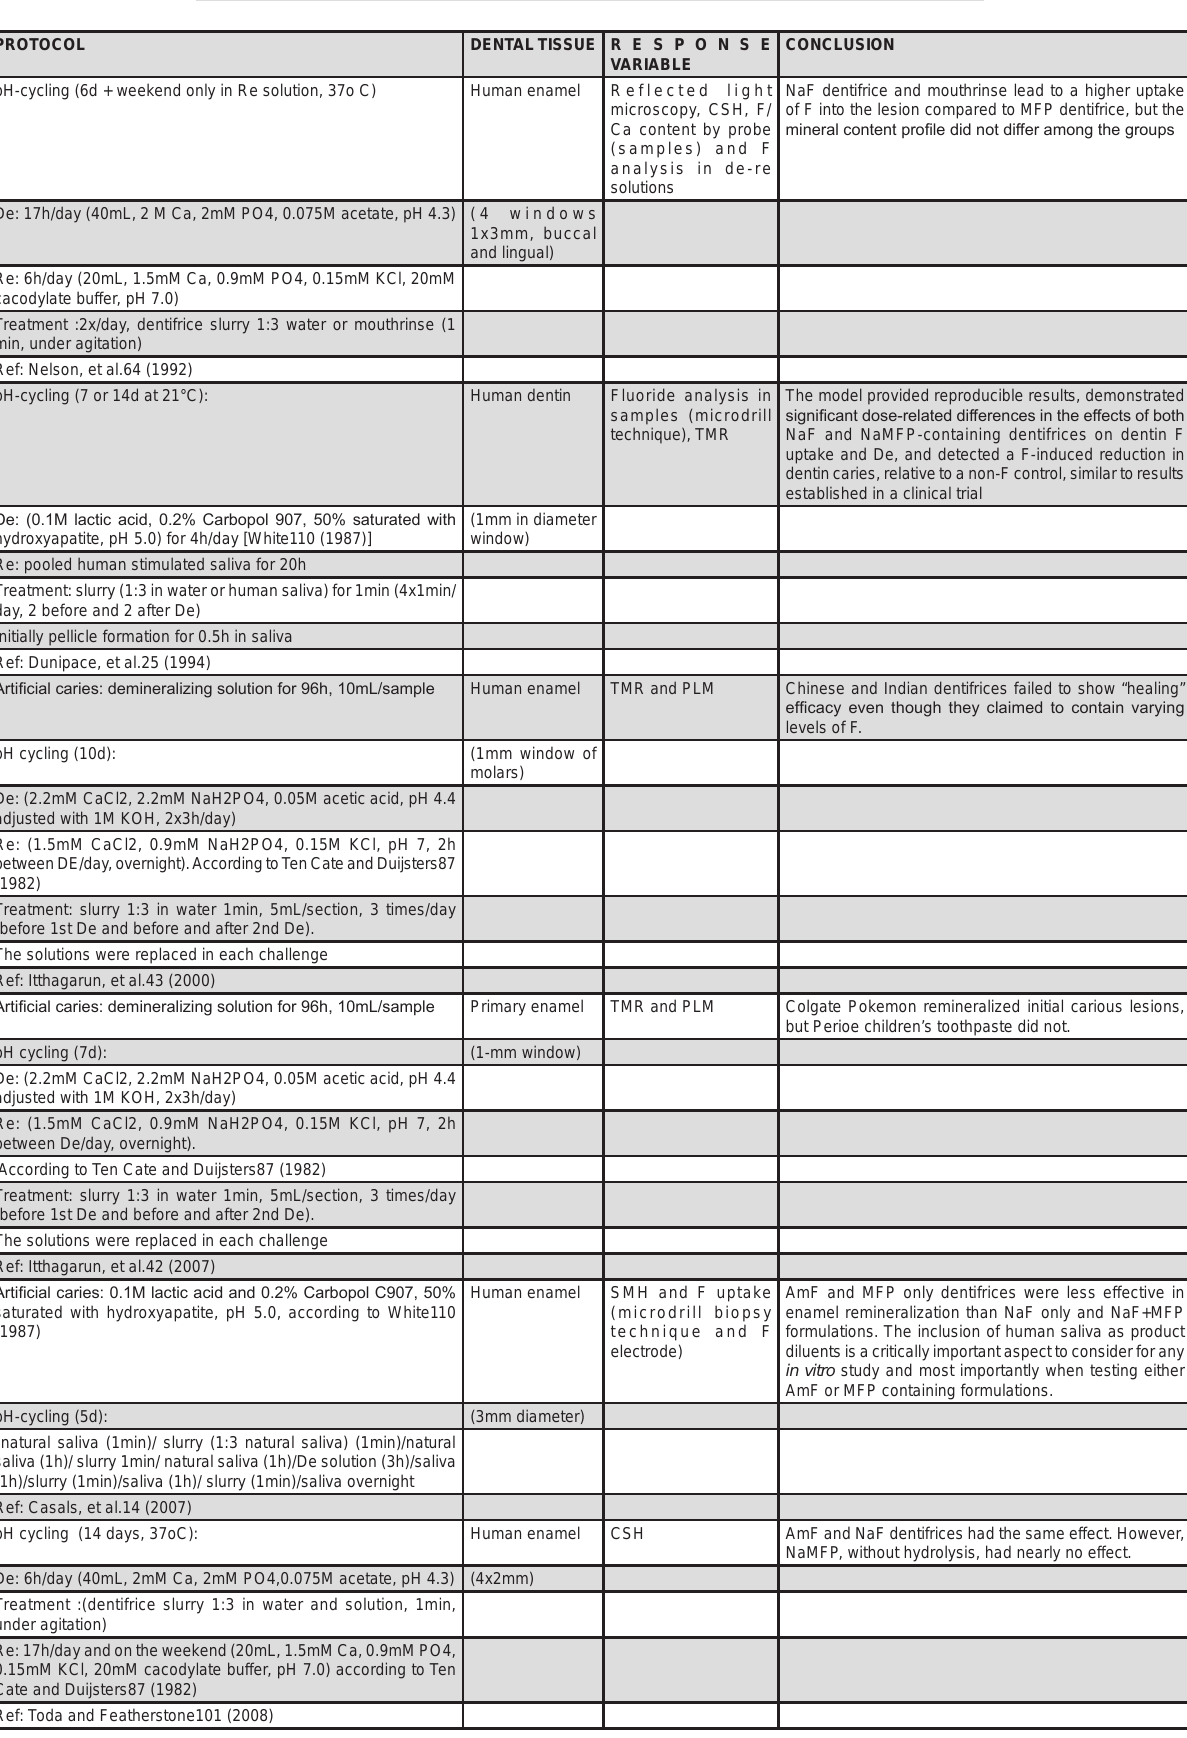
Figure 4- pH-cycling studies comparing the efficacy of different fluoride compounds present in dentifrices for caries